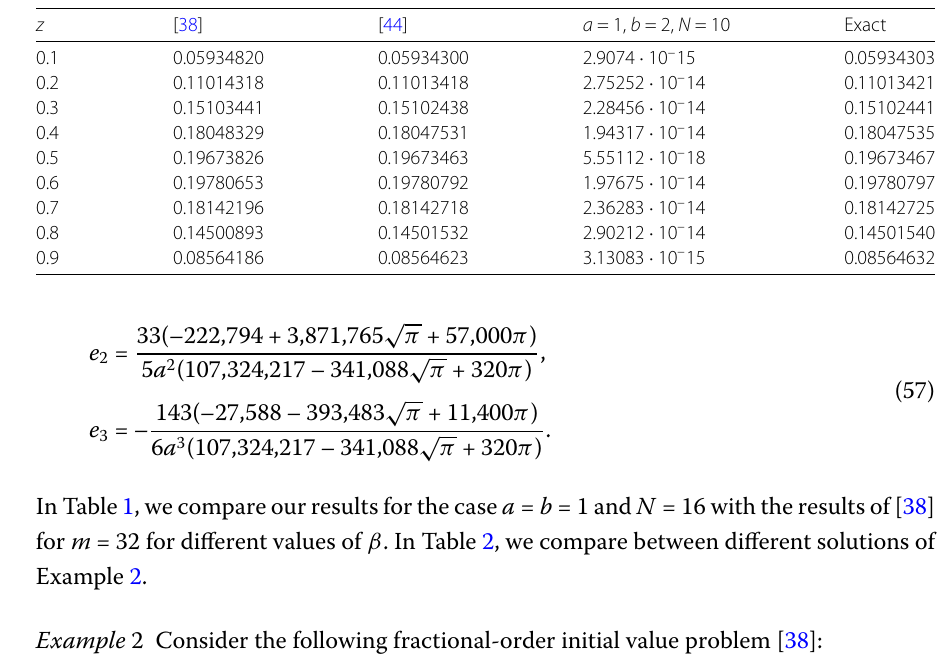
Table 2 Comparison between different errors E of Example